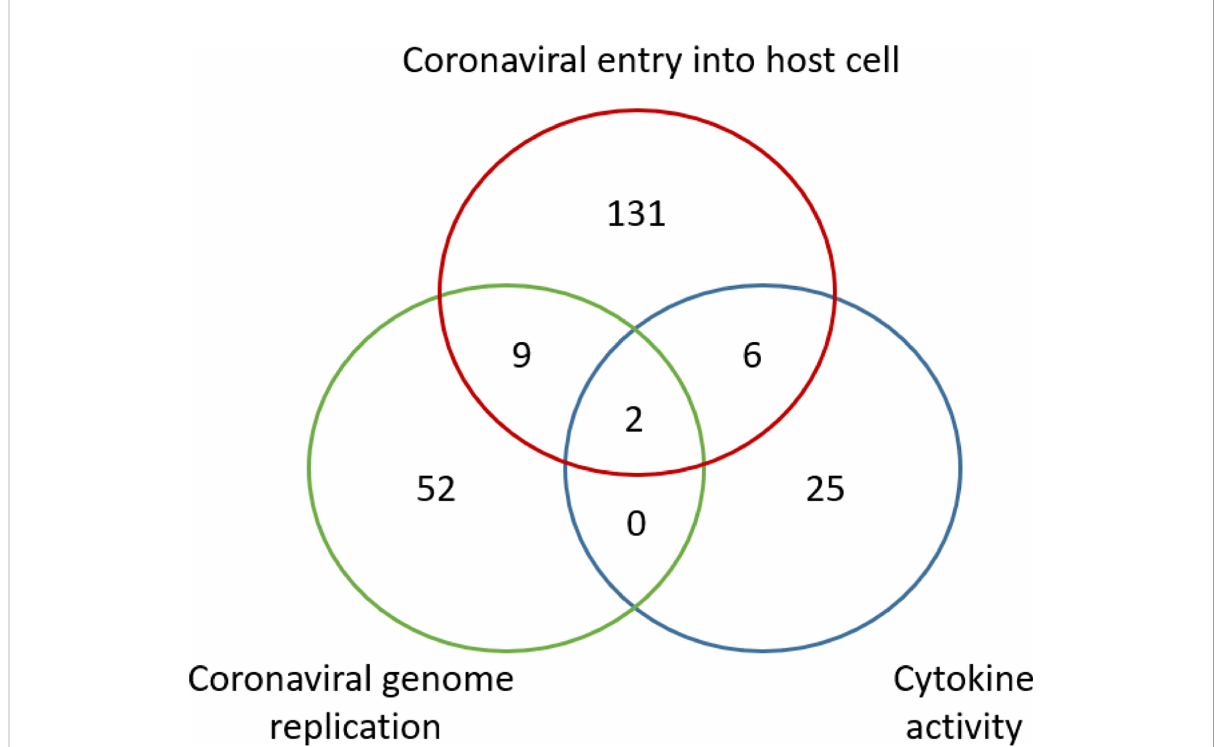
FIGURE 5 Venn Diagram of potential COVID-19 drugs based on the HPI Postulate drug cocktail strategy. A total of 232 drugs were identi fi ed to have their protein targets involving coronavirus entry, coronavirus genome replication, and host cytokine activity against COVID-19. Two drugs (i.e., copper and artenimol) were shared to have protein targets involved in all three processes. The drug screening study was performed using the DrugXplore program